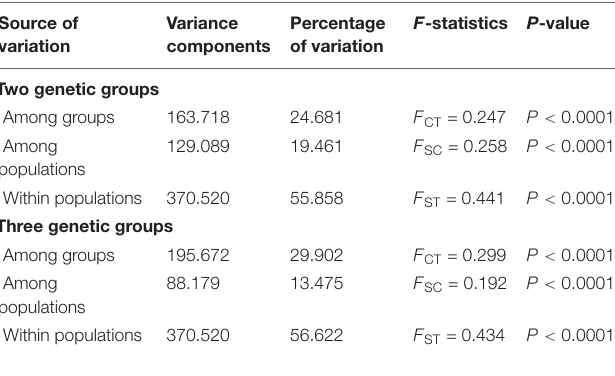
TABLE 3 | Results of the analyses of molecular variance (AMOVA) based on SNP